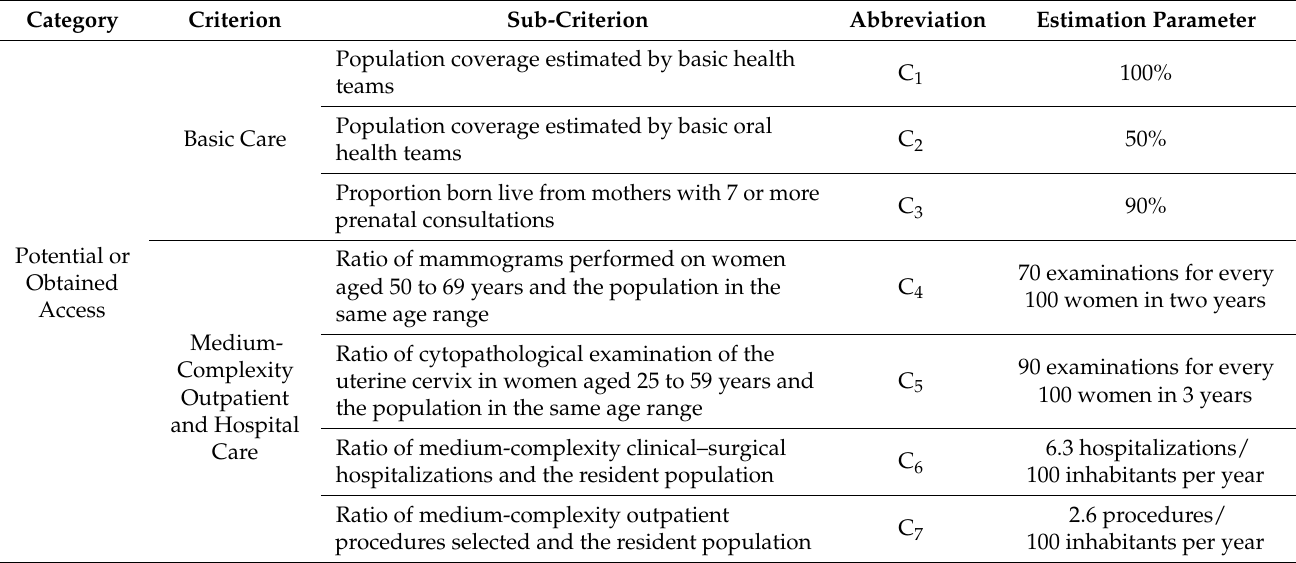
Figure 1. Procedure for resolving an MCDM/A problem. Table 1. Criteria and sub-criteria.